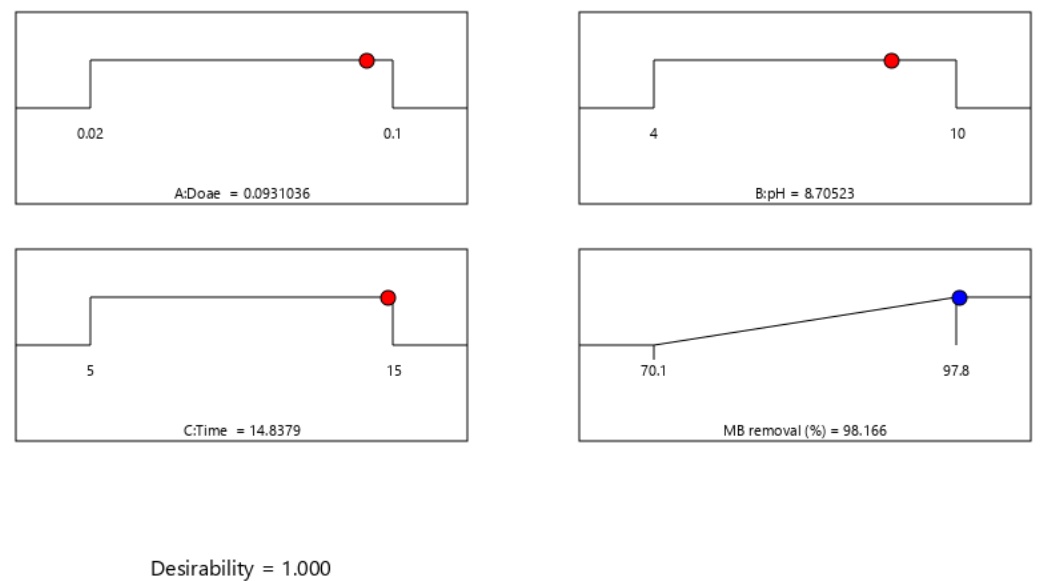
Figure 7. Desirability ramps for optimizing key adsorption factors of MB dye removal (%) using MSMPAC.